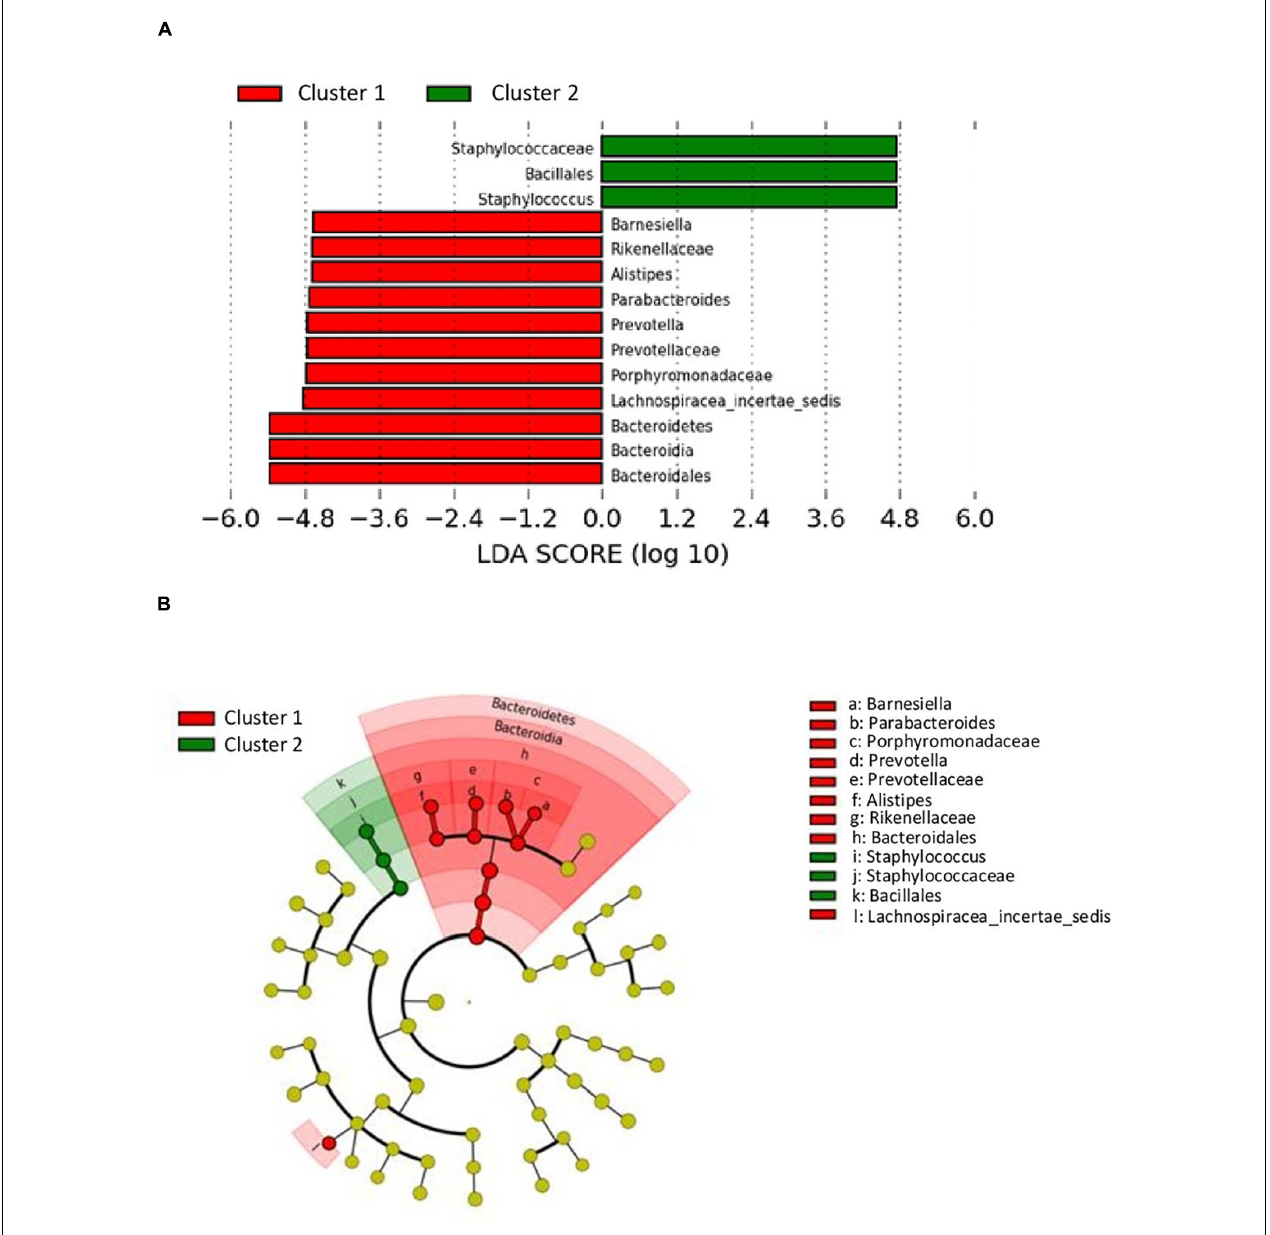
FIGURE 5 | LDA effect size (LefSe) analysis showing differences of taxa between clusters. (A) The histogram of the Linear discriminant analysis (LDA) scores illustrating the differentially abundant taxa between clusters. Horizontal bars represent the effect size for each taxon: red color indicates taxa enriched in cluster 1 group and green color indicates taxa enriched in cluster 2 group. (B) The cladogram illustrating the different taxonomic level from inside to outside that are significantly more abundant in cluster 1 group (red) and cluster 2 group